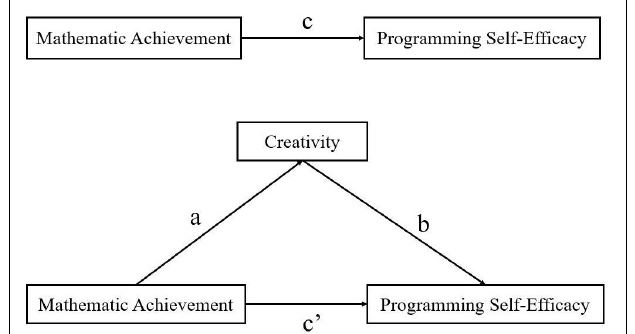
FIGURE 1 | The mediation model of creativity.